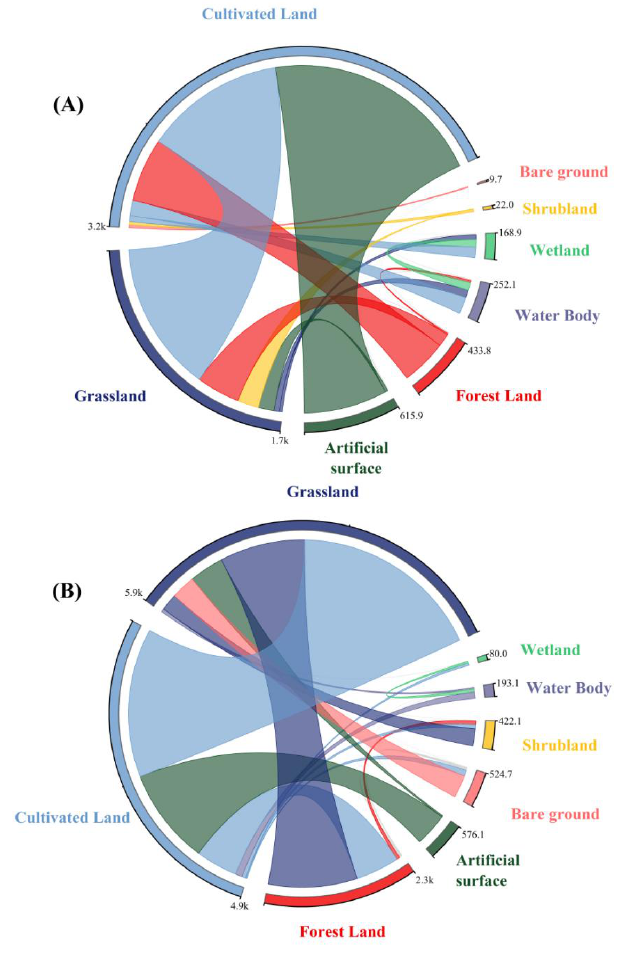
Figure 4. Land use type transfer area (km 2 ) matrix of the YRBS from 2000 to 2010 ( A ) and 2010 to 2020 ( B ).